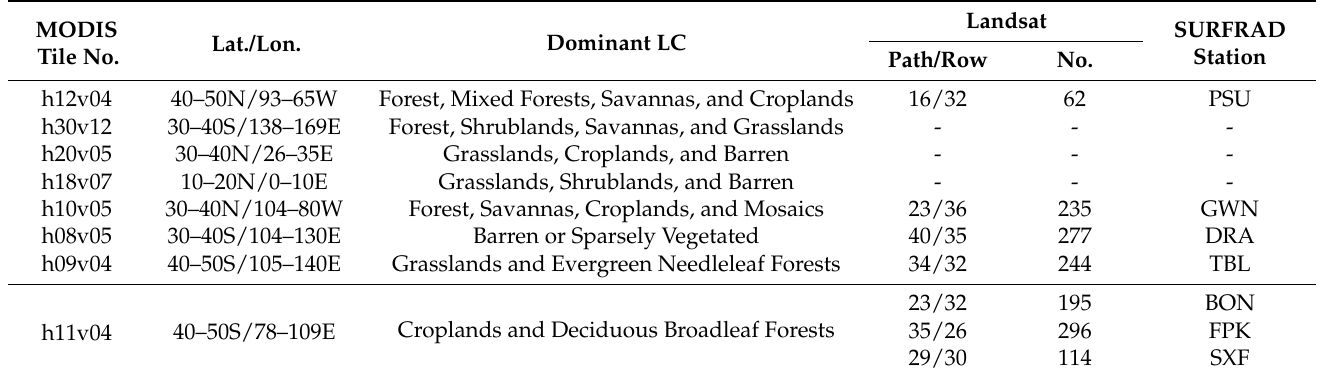
Table 1. Study areas represented by MODIS tile number and Landsat path/row, as well as the site of SURFARD